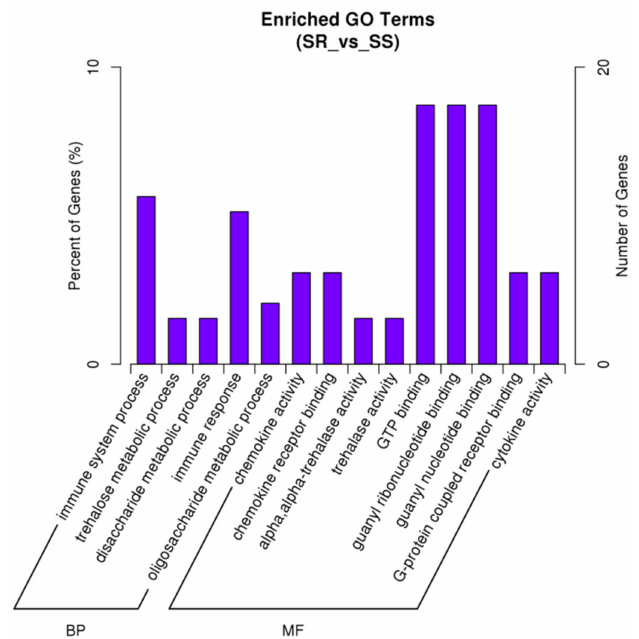
Figure 2. Gene ontology (GO) enrichment. The x -axis shows the second level GO terms from the biological process (BP) and molecular function (MF) while the y -axis shows the number and percentage of gene enrichment.